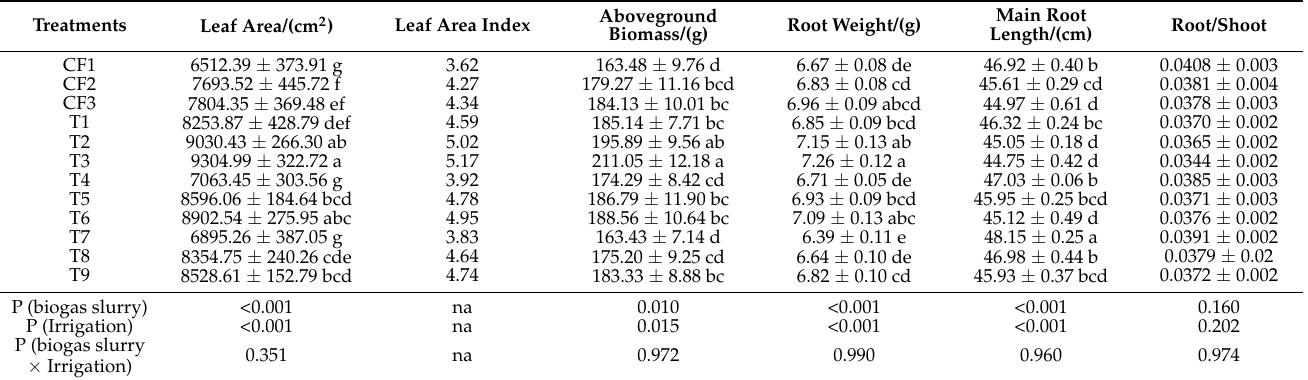
Table 2. Effects of different biogas slurry proportions and irrigation quantity rates on tomato